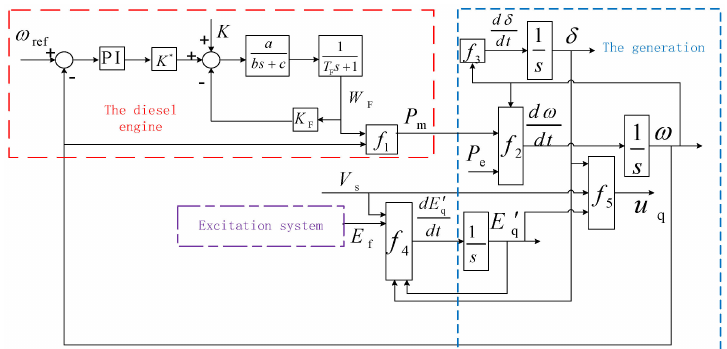
Figure 3. Diesel generator set